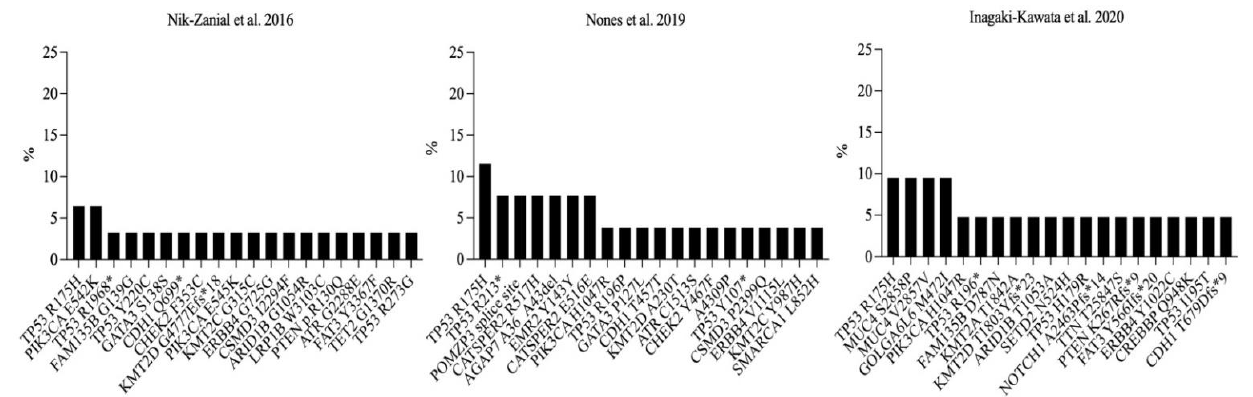
Figure 7. Top recurrent somatic mutations of germline BRCA1 -mutated breast cancer studies. X-axes indicate coding-region somatic mutations and the Y-axes indicate the percentage of all samples with the corresponding mutation. (* indicates stop gained variants)